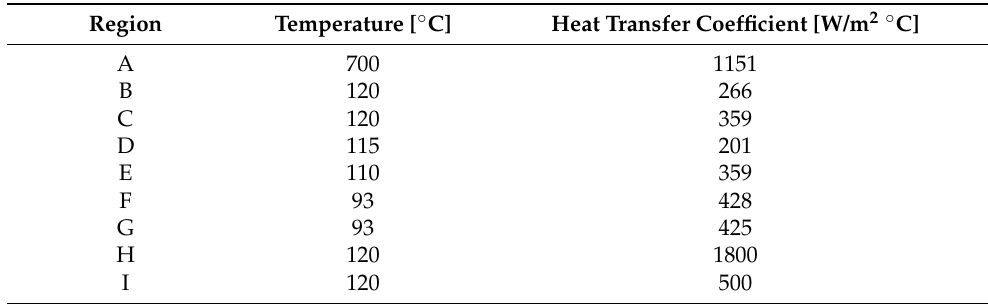
Table 3. Thermal boundary